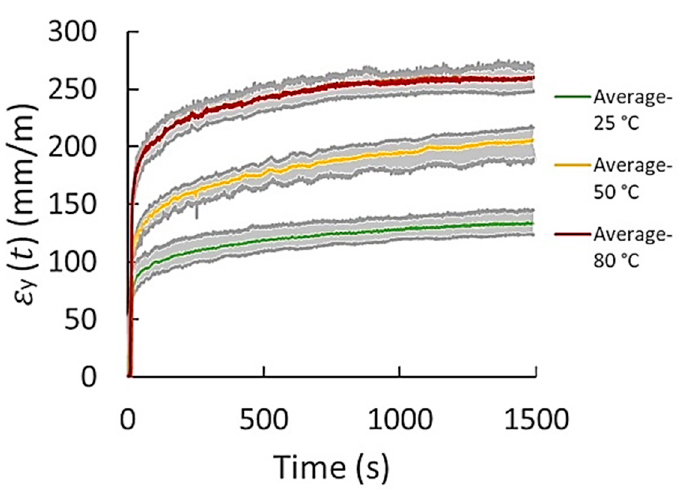
Figure 3. Dispersion of axial creep data (“y” direction) obtained from three test repeats for FKM at 600 kPa and different temperatures.